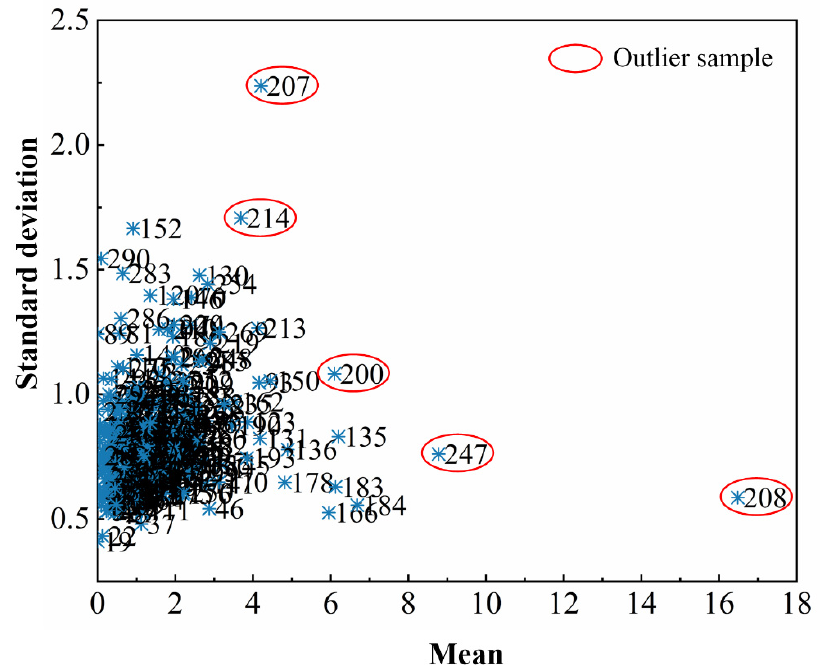
Figure 3. The distribution of mean values and standard deviations of all samples based on S1 spec- tral data.